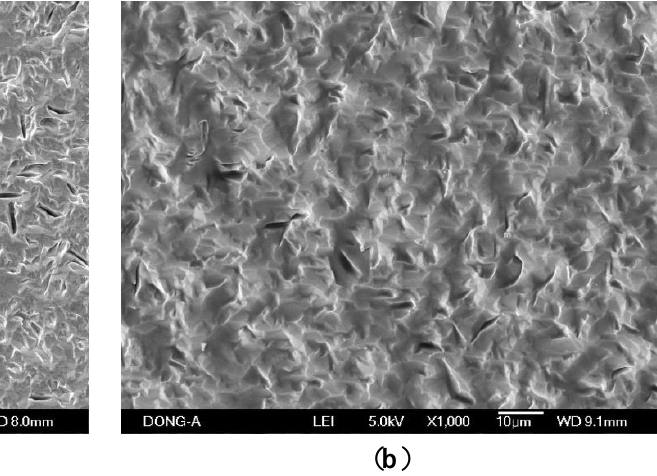
Figure 11. Photographs of scanning electron microscope of microbalance surface magnified by 1000 times: ( a ) blank; and ( b ) PVA